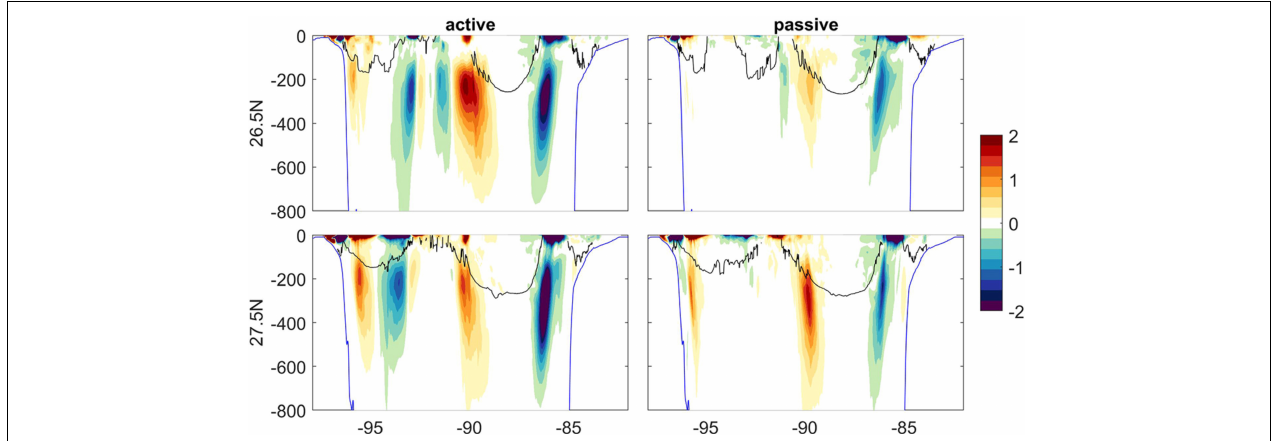
FIGURE 11 | Monthly averaged meridional freshwater transport across different sections in June 2015 in the SP runs, active, and passive. Black line indicates the depth of density 1,026 kg/m 3 . Blue line provides the bathymetry information. Units: m 3